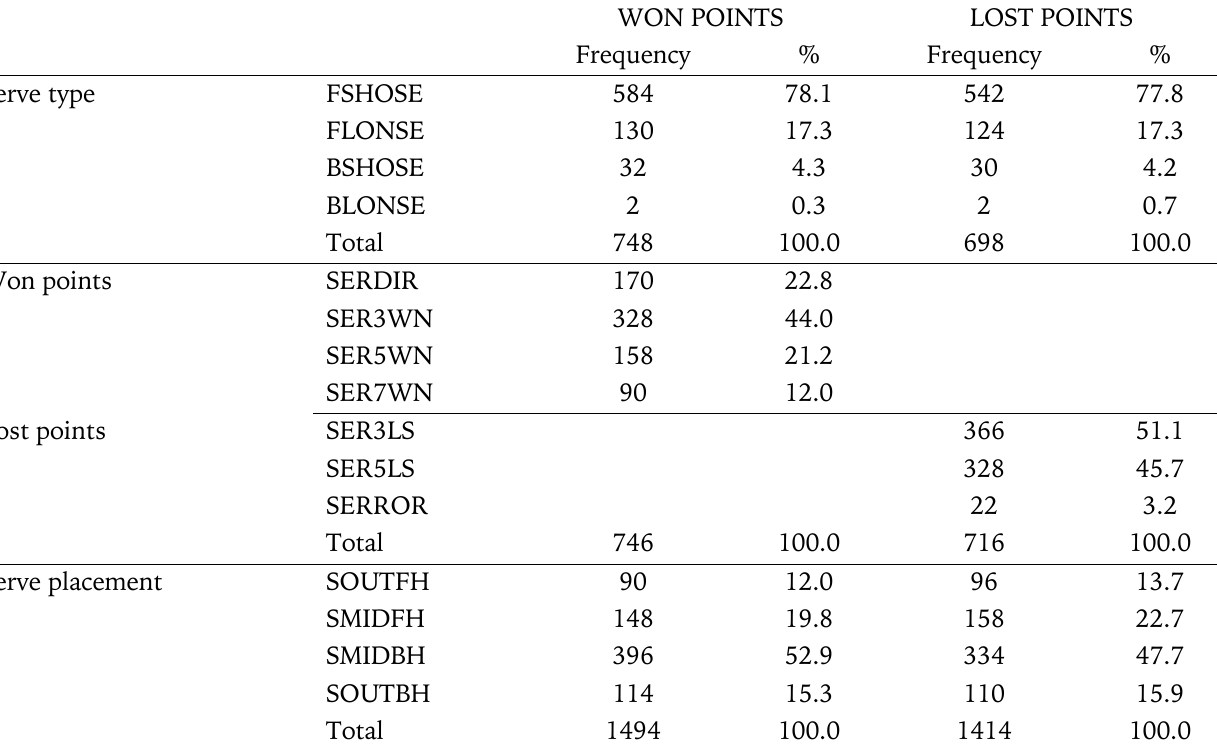
Results of analysis of serve activities for won/lost